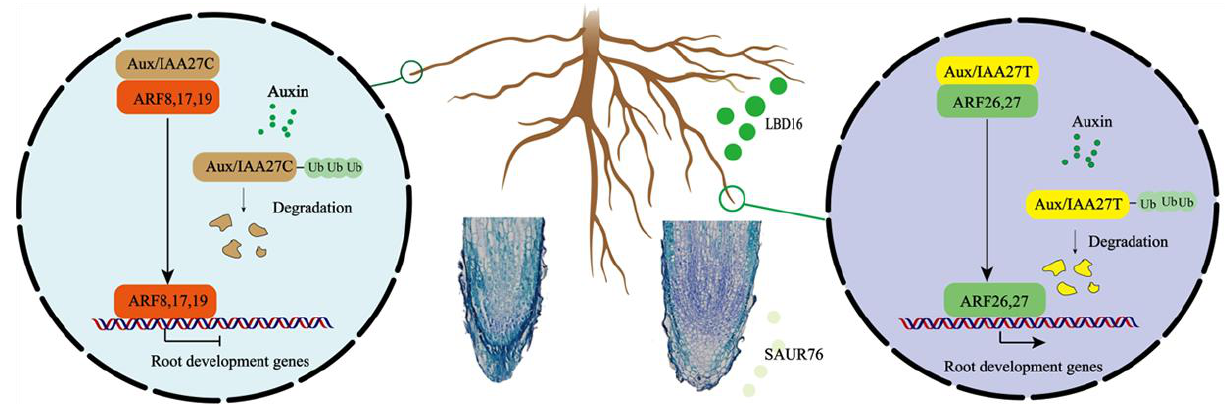
Figure 10. A working model of MdIAA27-regulated adventitious root growth and development in response to phosphorus stress. Yellow domains denote the IAA27-T mutant proteins and brown domains denote the IAA27-C proteins. Green domains denote the positive ARF proteins and red domains denote the negative ARF proteins. Arrows indicate positive effects, whereas lines ending with a short bar indicate suppressive interactions.